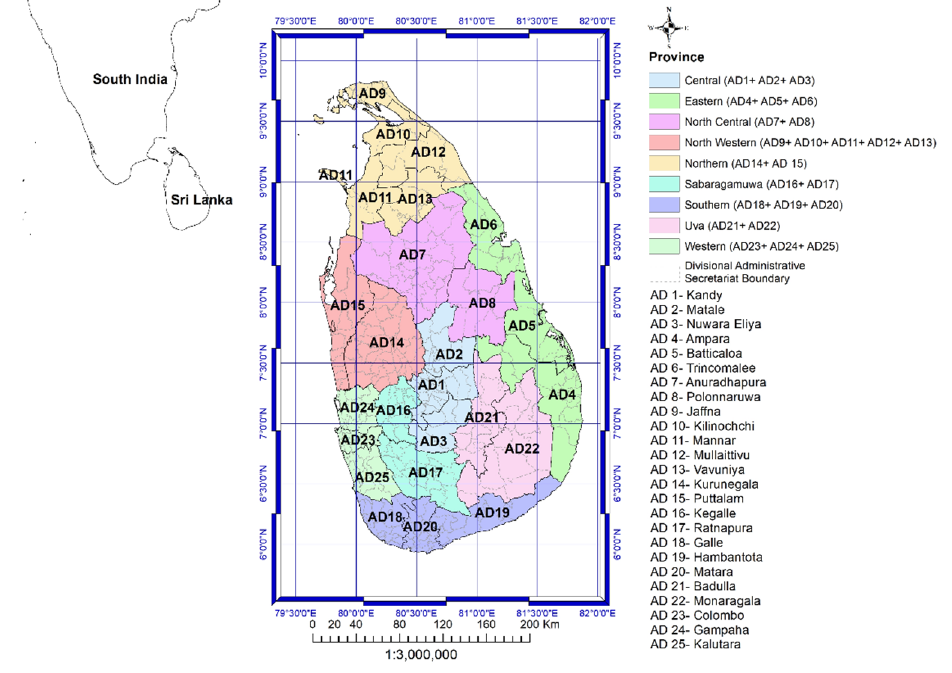
Figure 1. Existing provinces and administrative districts (AD1-AD25) in Sri Lanka.